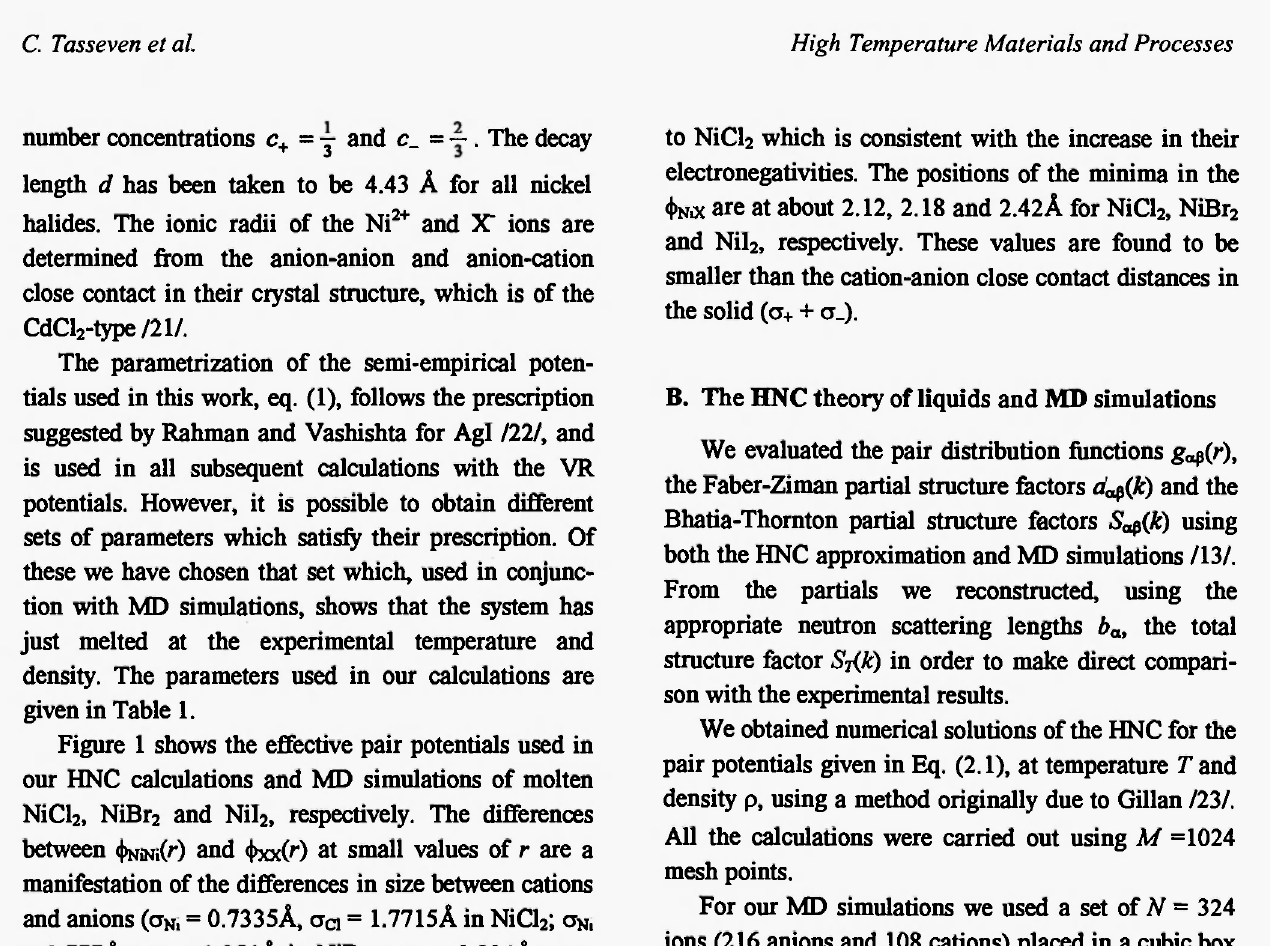
, NiBr and Nil . Units of length are in A and of energy are in 2 2 2 e 2 /Ä= 14.399